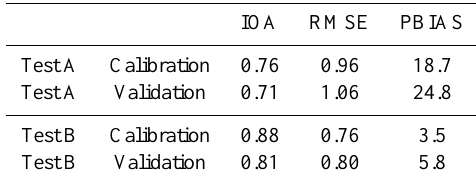
Table 4. Index of goodness of fit for calibration and validation